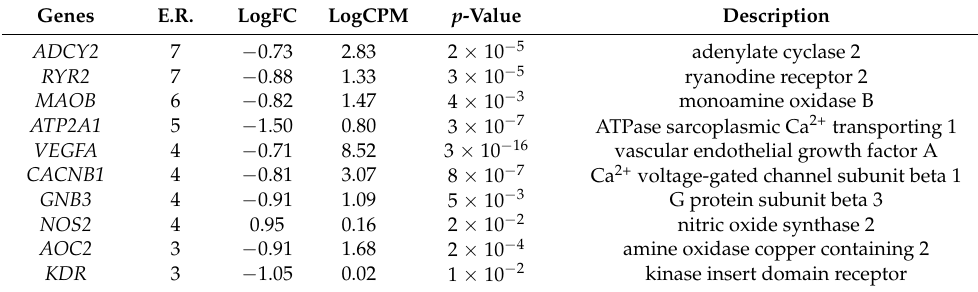
Figure 6. Kyoto encyclopedia of genes and genomes (KEGG)-based pathway analysis of differentially expressed genes (DEGs) in response to heat stress granulosa cells. All the significantly ( p < 0.05) regulated pathways and DEG enrichment ratios are illustrated. Table 3. Pathway analyses of differentially expressed genes in response to heat stress, checked for top 10 DEGs abundantly enriched in various pathways, are listed along with their statistics details and